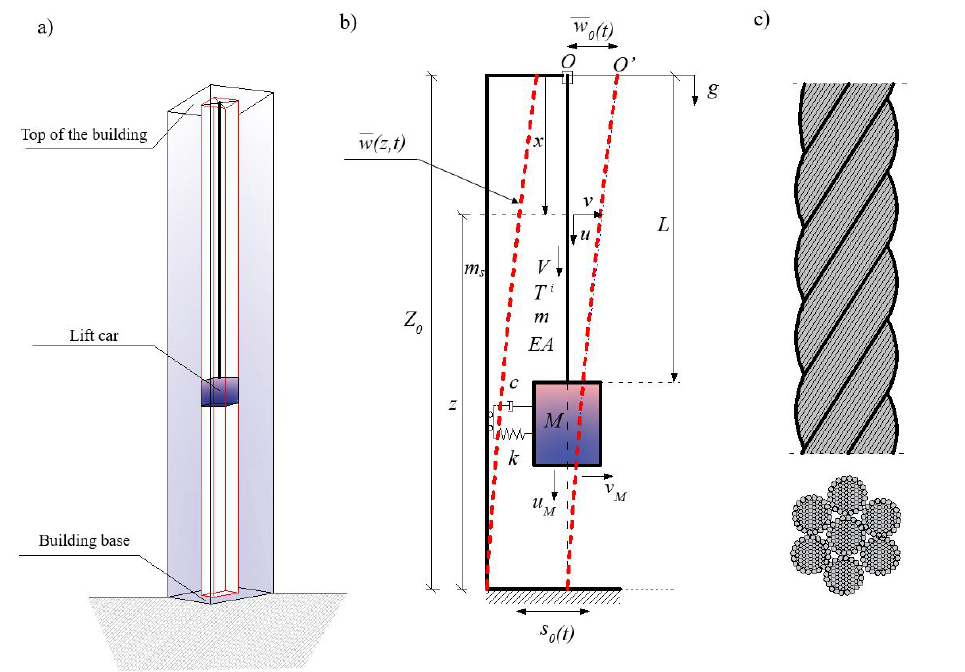
Figure 1. ( a ) High-rise building with lift installation; ( b ) Schematic model of cable-mass-spring system [9]; ( c ) Lift cable